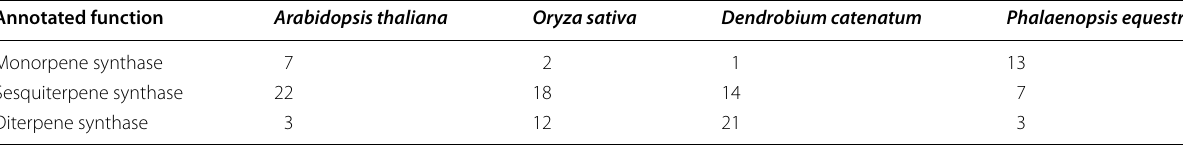
Table 3 The annotated function of TPS of Arabidopsis , Oryza and orchids Annotated